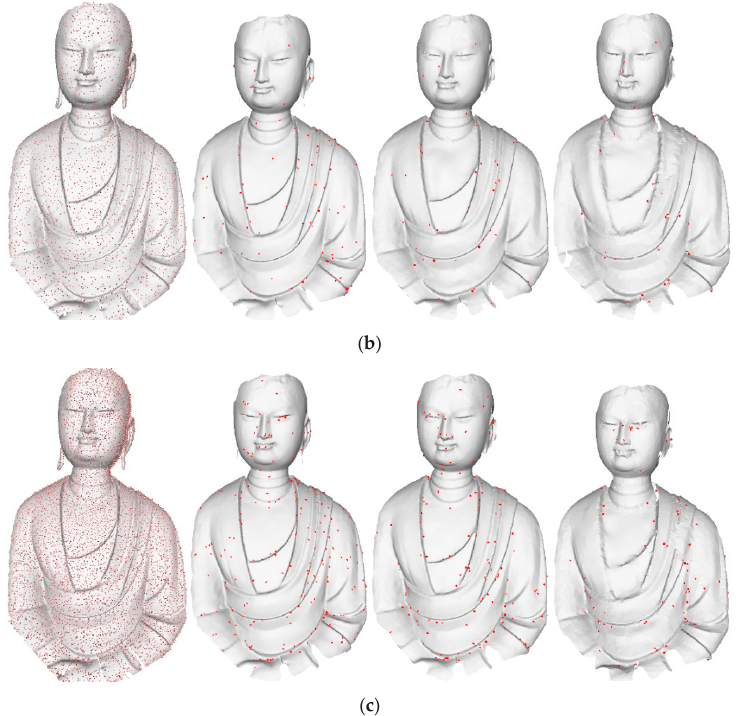
Figure 15. Noisy data and simplified results of level δ = 2.0, 4.0, and 6.0 when ( a ) 1% of points are noise points, ( b ) 2% are noise points, and ( c ) and 5% are noise points.